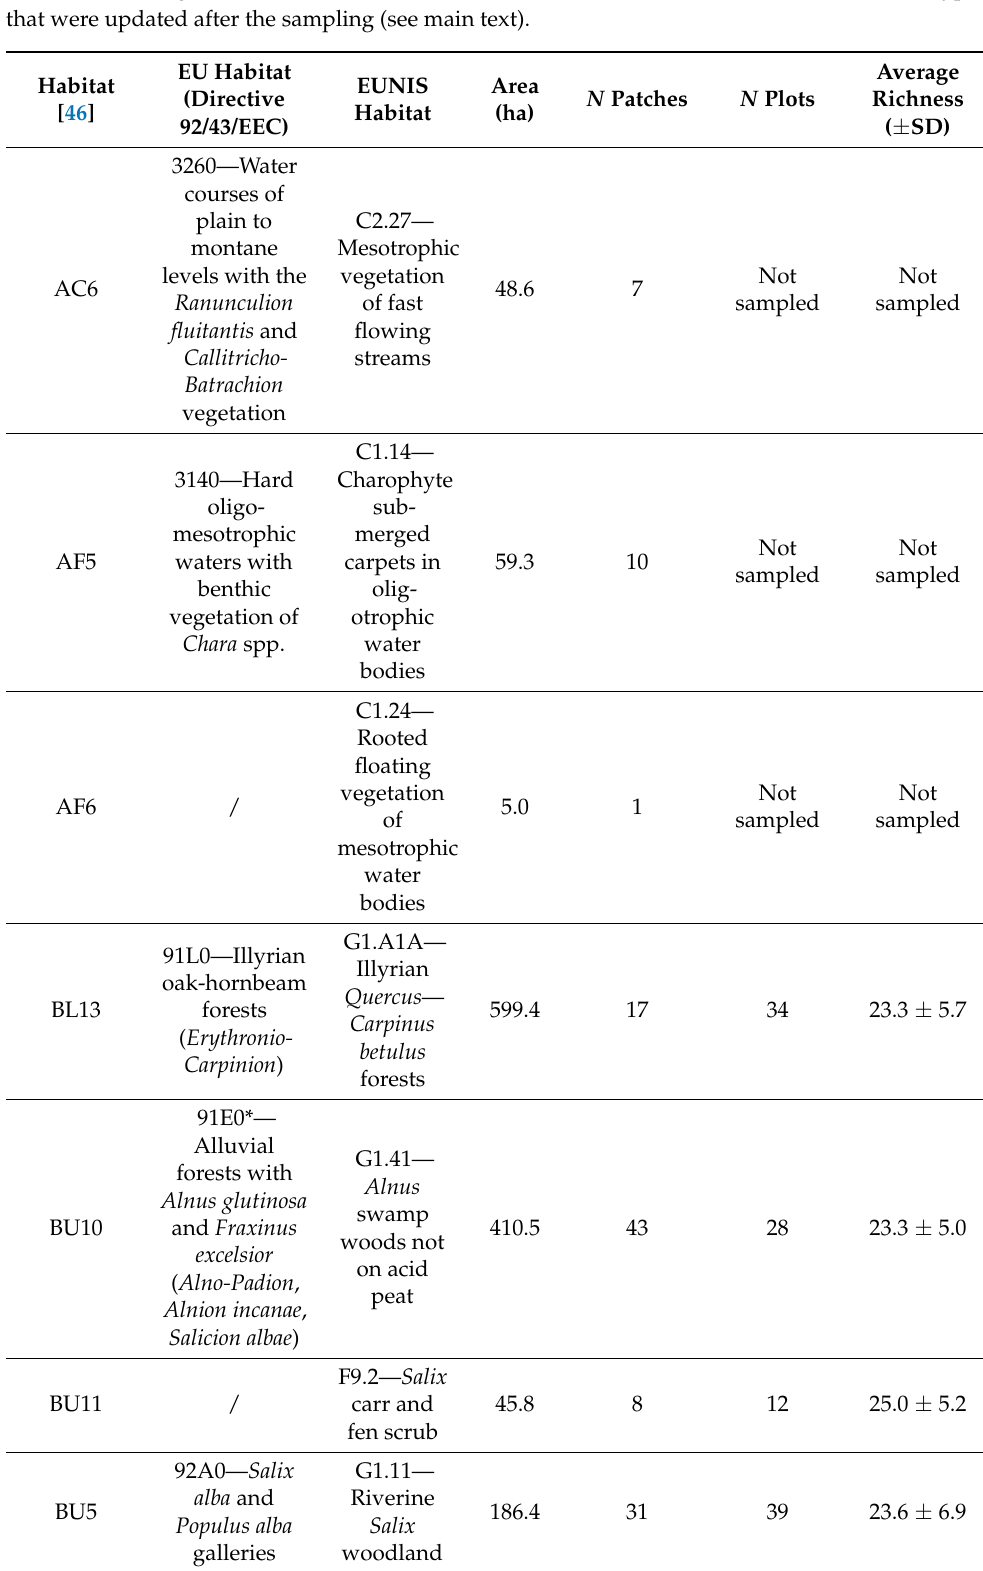
Table 1. Habitat codes of the area according to Poldini et al. [47] and correspondence with EU and EUNIS habitat classification along with descriptive statistics of the study area (i.e., area, number of patches, number of plots and average richness). Asterisk (*) in EU habitat codes denotes priority habitats according to Habitats Directive. Plus (+) before EUNIS habitat codes denotes habitat types that were updated after the sampling (see main